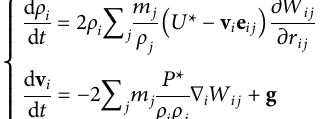
FIGURE 2 Schematic diagram of projectile impacting aluminum